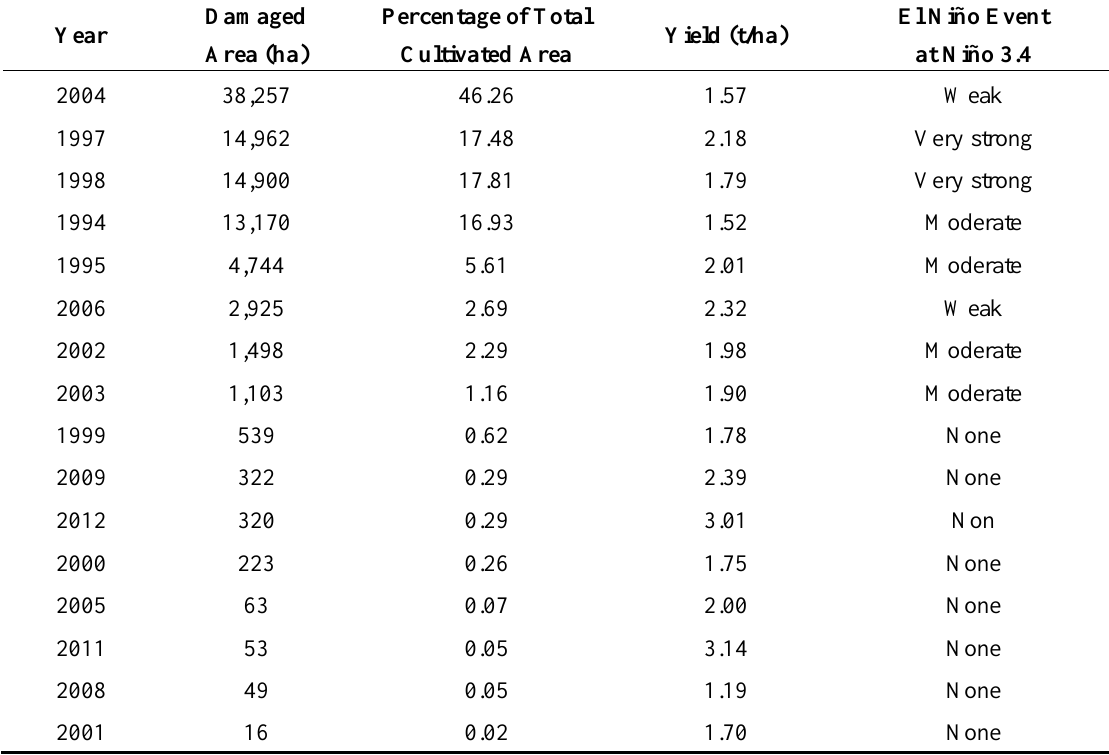
Table 3. Drought-related rice damage in Kampong Speu province and ENSO events between 1983 and 2012.